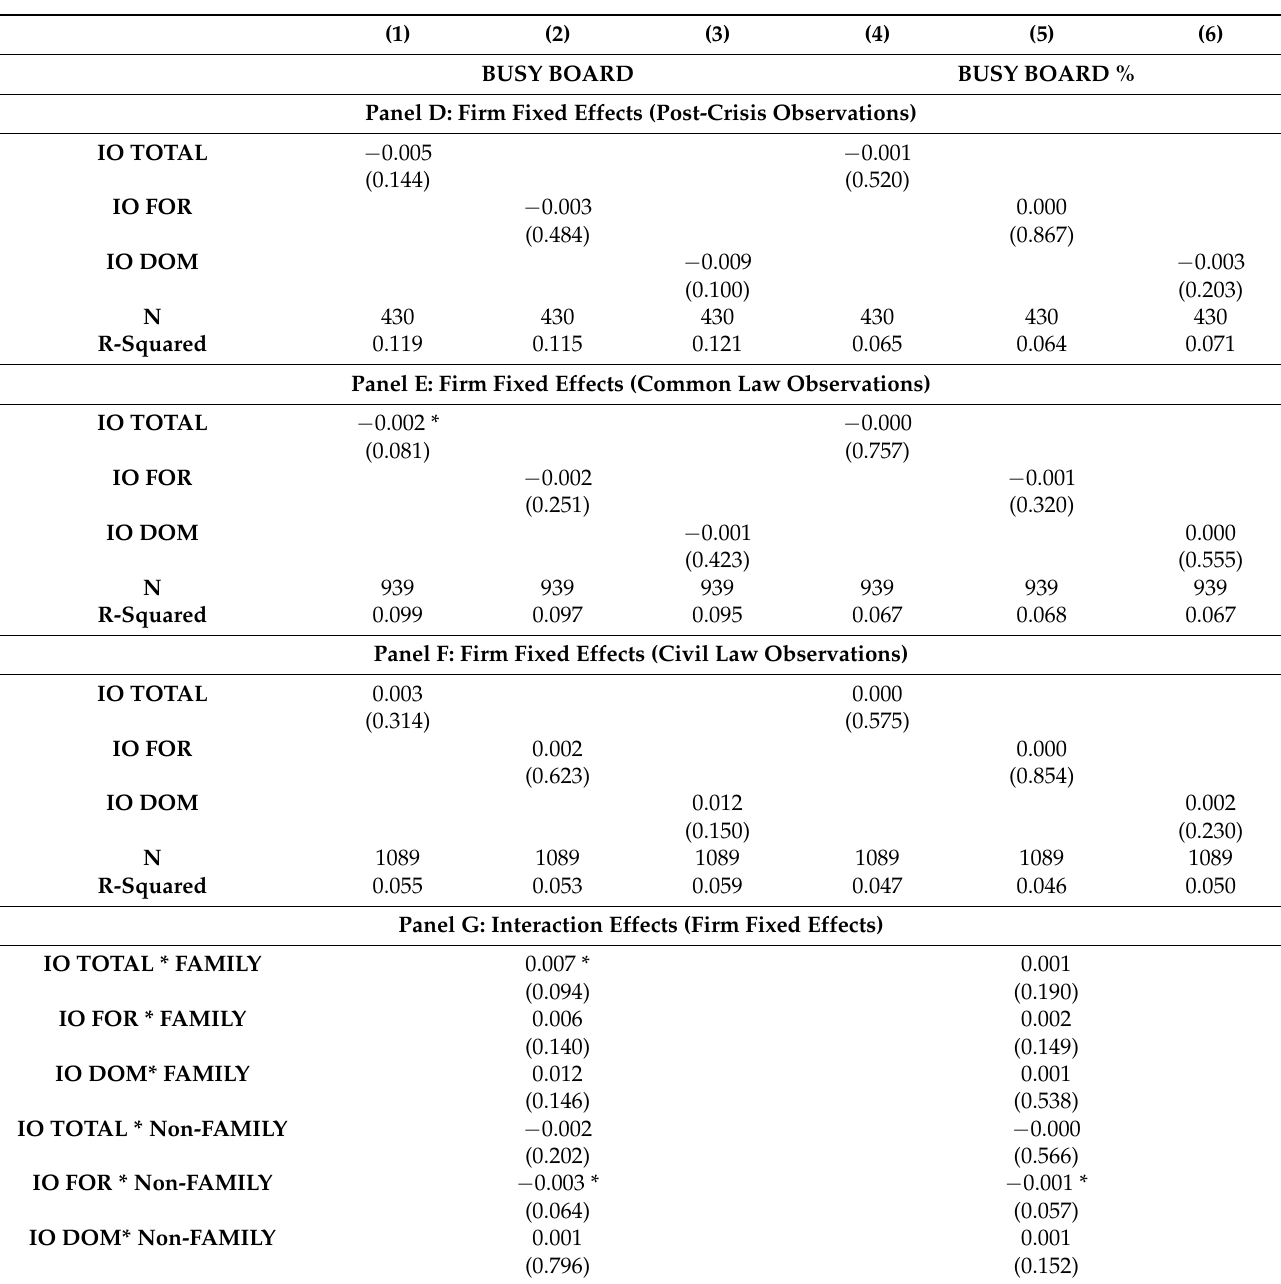
Panel G: Interaction Effects (Firm Fixed